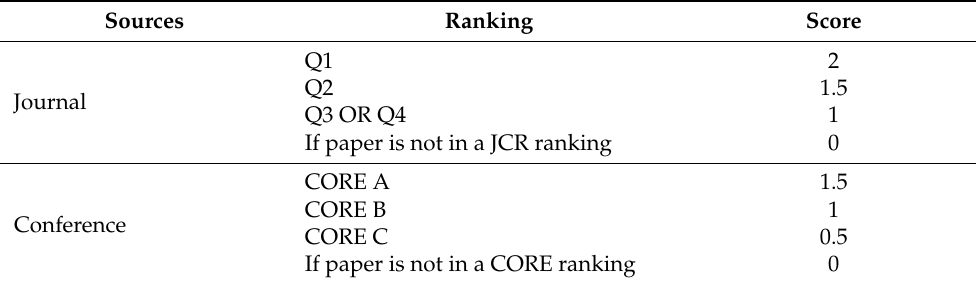
Table 7. Quality criteria. JCR: Journal Citation Reports.